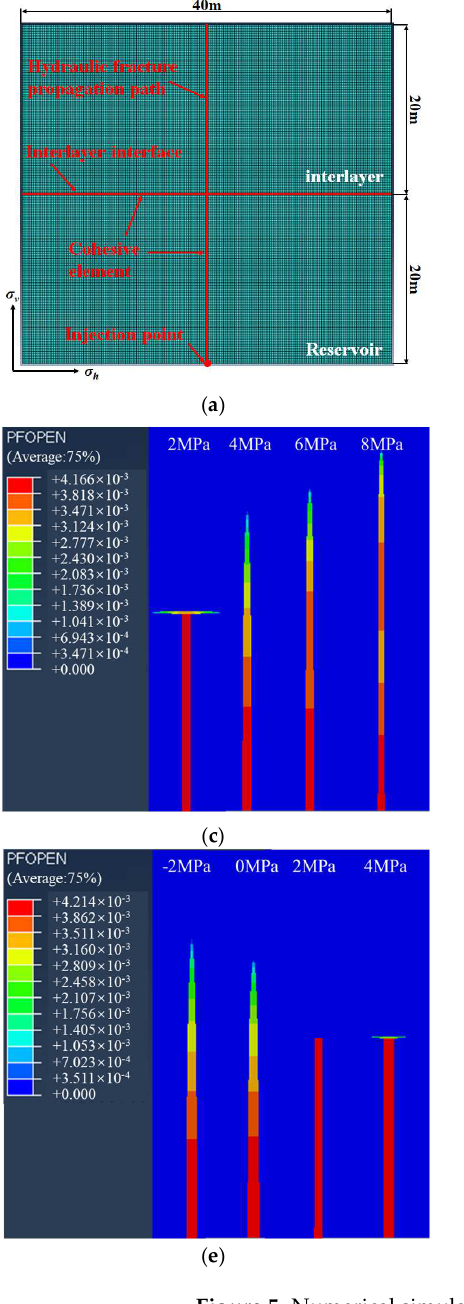
Figure 5. Numerical simulation results under different geological parameters: ( a ) Schematic diagram of model meshing; ( b ) Interlayer interface strength; ( c ) Vertical stress difference; ( d ) Interlayer stress difference; ( e ) Tensile strength difference; ( f ) Elastic modulus